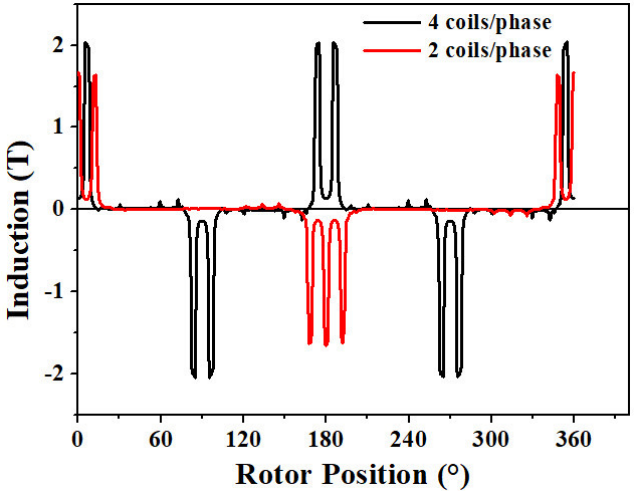
Figure 11. Air-gap flux density of 4-phase TDSPM with 2 and four coils/phase optimal structures versus rotor